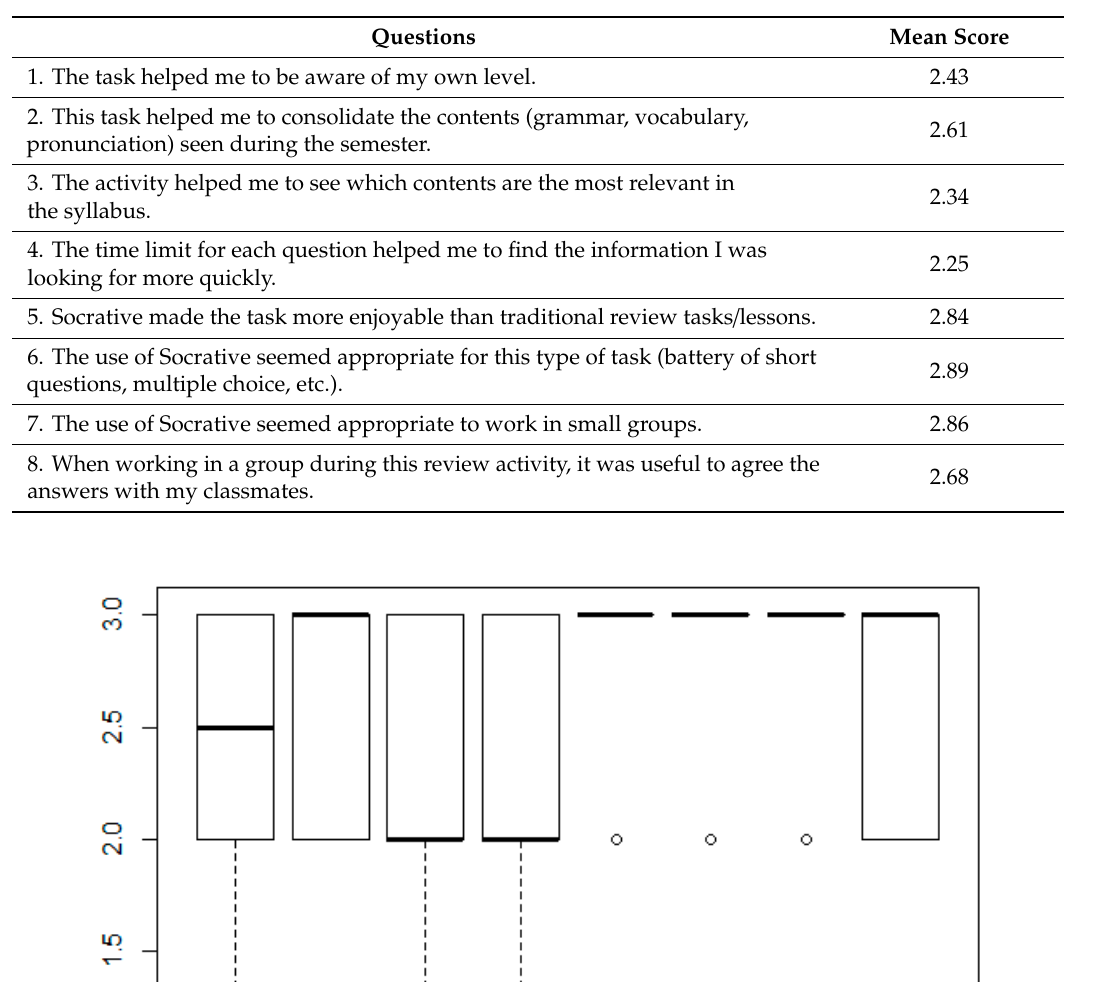
Table 4. Cooperative review game: Questions and mean scores.